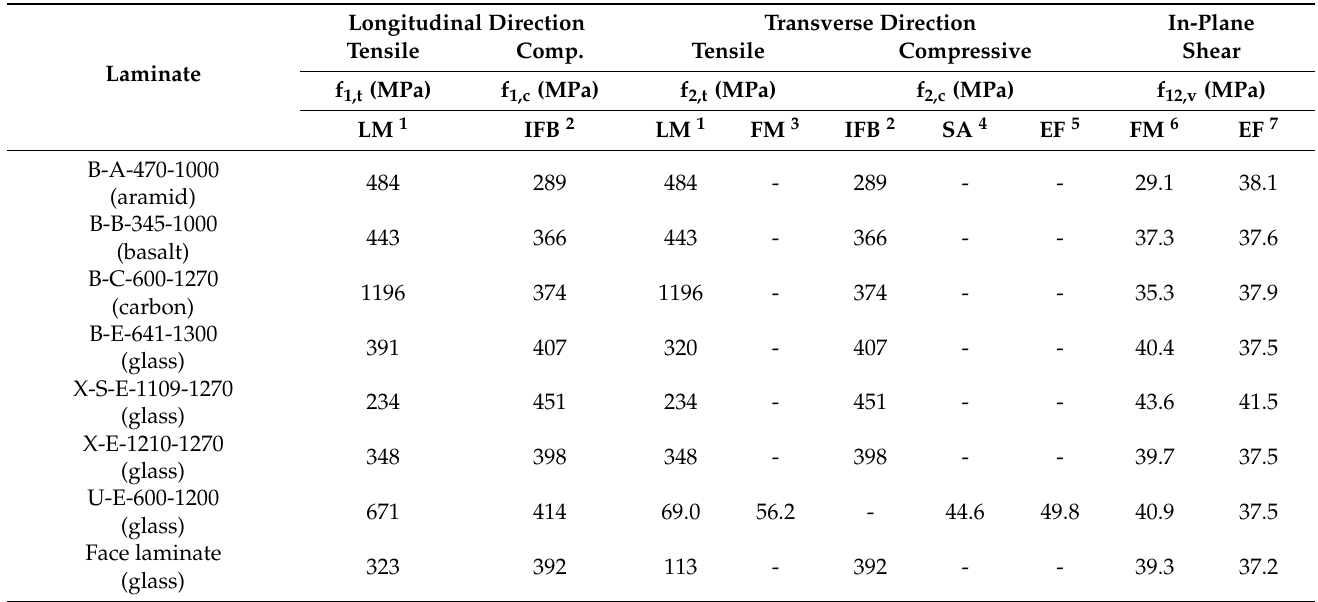
Table 9. Strength parameters for all specimens calculated according to different micromechanical theories. Longitudinal Direction Transverse Direction Comp. Laminate